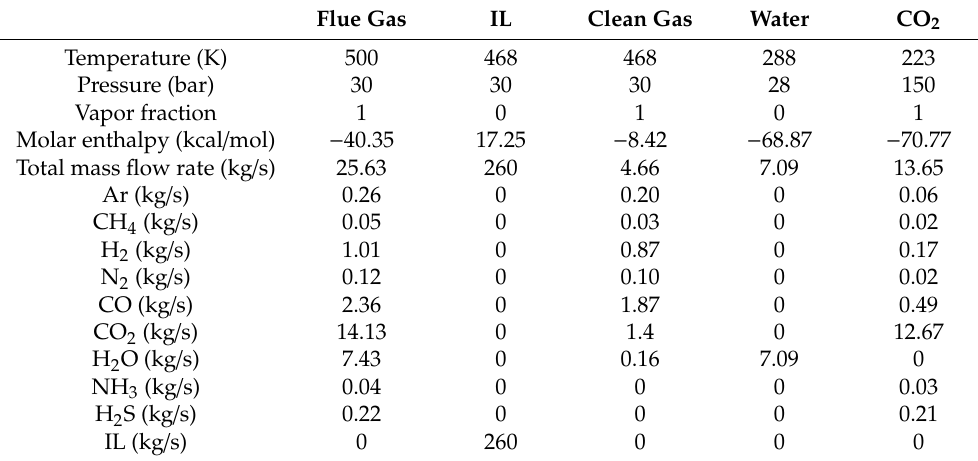
Table 7. Material and energy balances for inputs and outputs obtained for the simulation of carbon dioxide capture process in Aspen Plus ® .